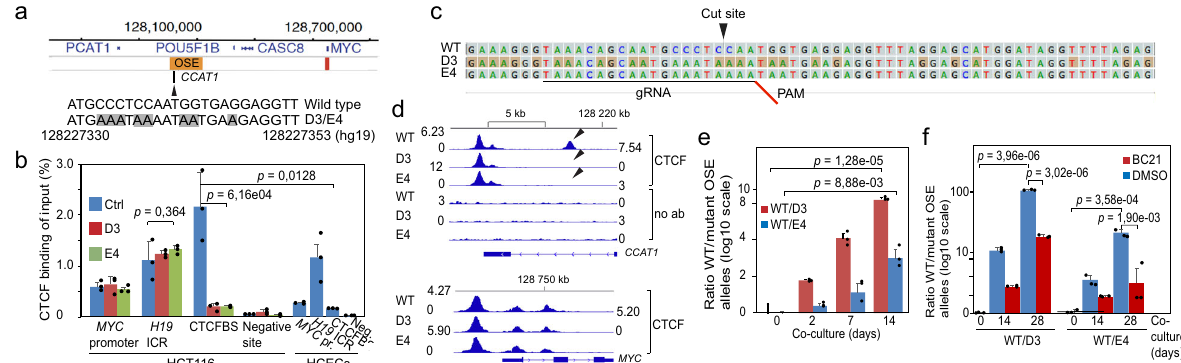
Fig. 1 The CTCFBS within the OSE-speci fi c eRNA gene ( CCAT1 ) confers a proliferative advantage to the HCT-116 cells. a The position of the CCAT1 - speci fi c CTCFBS within the OSE is indicated (black arrow). The core binding sequence was modi fi ed at 8 bases, as marked by gray boxes in the panel, by CRISPR editing. Orange boxes depict enhancer regions. b ChIP analyses of the occupancy of the CTCFBS within the OSE. The MYC promoter and the H19 ICR were used as positive controls. Neg. CTCF negative site (see Methods). c DNA sequences in the edited CTCFBS in comparison to WT HCT-116 cells. d ChIP-seq pro fi les of CTCF binding patterns to a region encompassing the OSE (upper) and MYC (lower) regions. The ChIP-seq data, which is visualized in relation to a genome browser snapshot, was normalized from three independent experiments for WT HCT-116, D3, and E4 cells. The boxed motif, representing the CCAT1 gene region, is enlarged to identify the edited CTCFBS within its intron. The arrows identify the edited CCAT1 -speci fi c CTCFBS. e Co-cultures of wild type and mutant HCT-116 cells harvested at the indicated time points, followed by qPCR analyses of the proportion of WT and mutant CTCFBSs, respectively. f The effect of BC21 on the relative growth rate of the WT, D3, and E4 cells. All the genomic coordinates use hg19 as a reference genome. The data represent in all instances the average of three independent experiments with indicated standard deviation. The p values were calculated by the two-tailed Student ’ s t